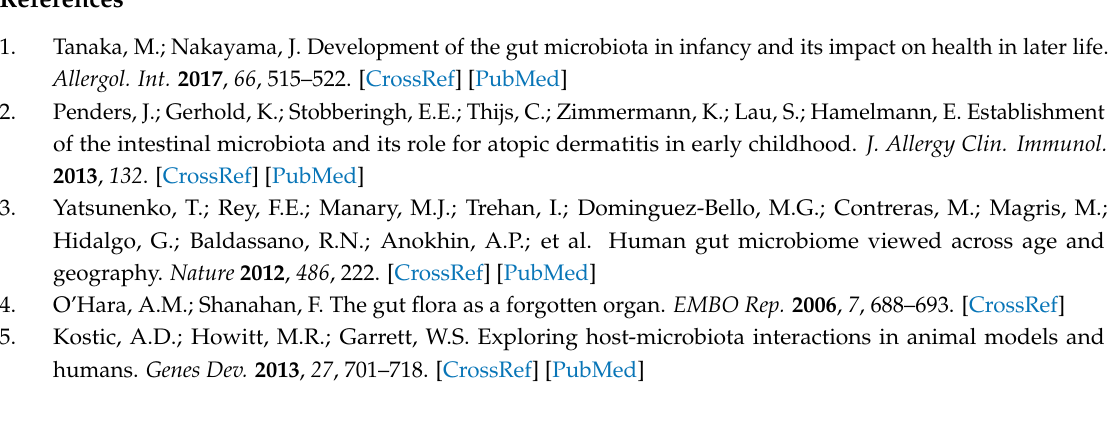
Table S1: Relative abundance (percentage) of microbial operational taxonomic units (OTUs) in the stomach of piglets in the microbiota transplantation (MFMT), amoxicillin treatment (AM), and control (CO) groups; Table S2: Relative abundance (percentage) of microbial operational taxonomic units (OTUs) in the ileum of piglets in the microbiota transplantation (MFMT), amoxicillin treatment (AM), and control (CO) groups; Table S3: Relative abundance (percentage) of microbial operational taxonomic units (OTUs) in the colon of piglets in the microbiota transplantation (MFMT), amoxicillin treatment (AM), and control (CO)